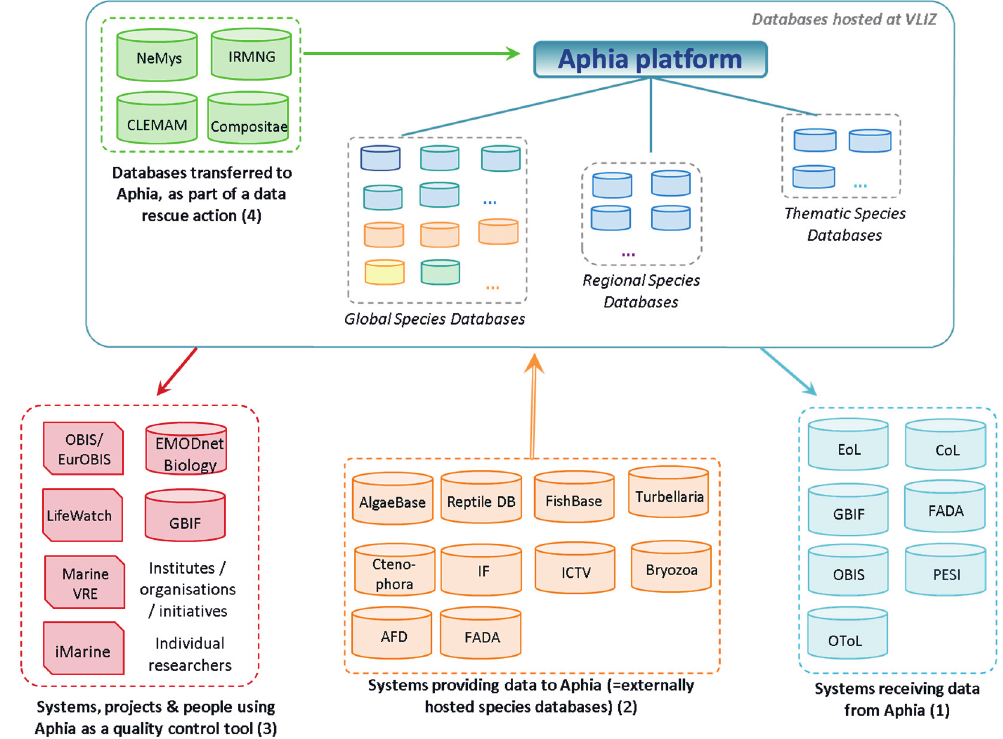
Figure 3. Relationships of Aphia with other data systems and projects. Four kinds of categories can be identified: (1) as a data supplier to other systems, (2) as an integrator of relevant data from other systems, (3) as a quality control tool for the (taxonomic) content of other systems, projects and initiatives or (4) as an infrastructure to host and rescue databases at the risk of being lost. NeMys: World List of Free-living Marine Nematodes; IRMNG: Interim Register for Marine & Non-marine Genera; CLEMAM: Checklist of